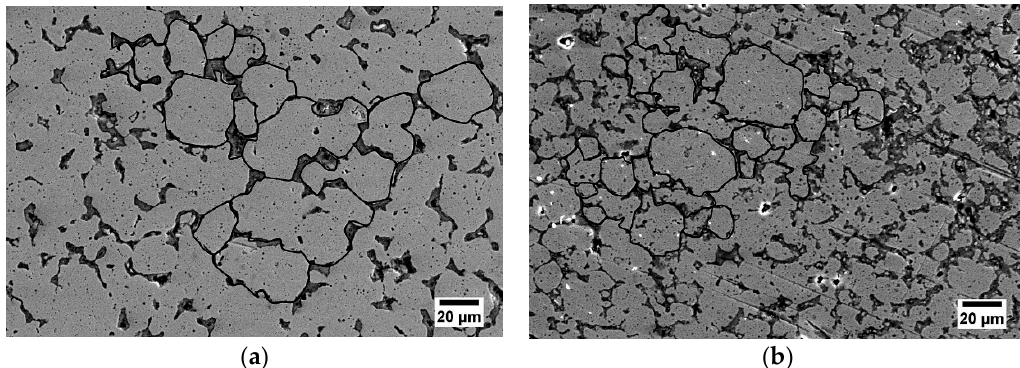
Figure 5. SEM images of the sintered austenitic stainless steel at: ( a ) 1150 °C and ( b ) 1200 °C.